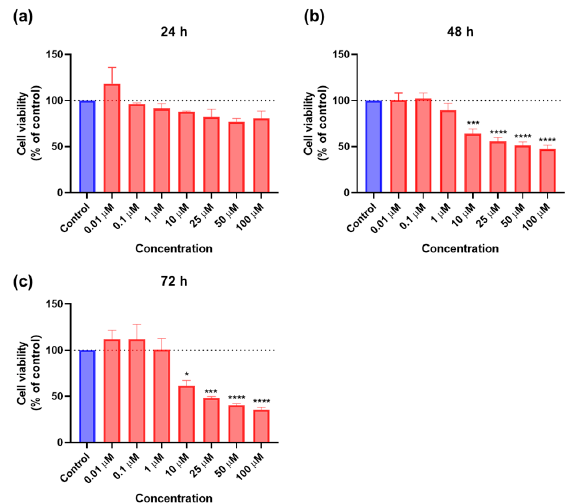
Figure 1. Cytotoxic results of PC-3 after exposure to increasing concentrations of 5-FU (0.01–100 µ M) for 24 h ( a ), 48 h ( b ), and 72 h ( c ). Control cells were treated with 0.01% DMSO (vehicle). Cell viability was obtained using the MTT assay and the results are given as the mean ± SEM (24 h n = 3, 48 h, and 72 h n = 6). * Statistically significant vs. control (vehicle) at p < 0.05; *** statistically significant vs. control (vehicle) at p < 0.001; **** statistically significant vs. control (vehicle) at p < 0.0001.